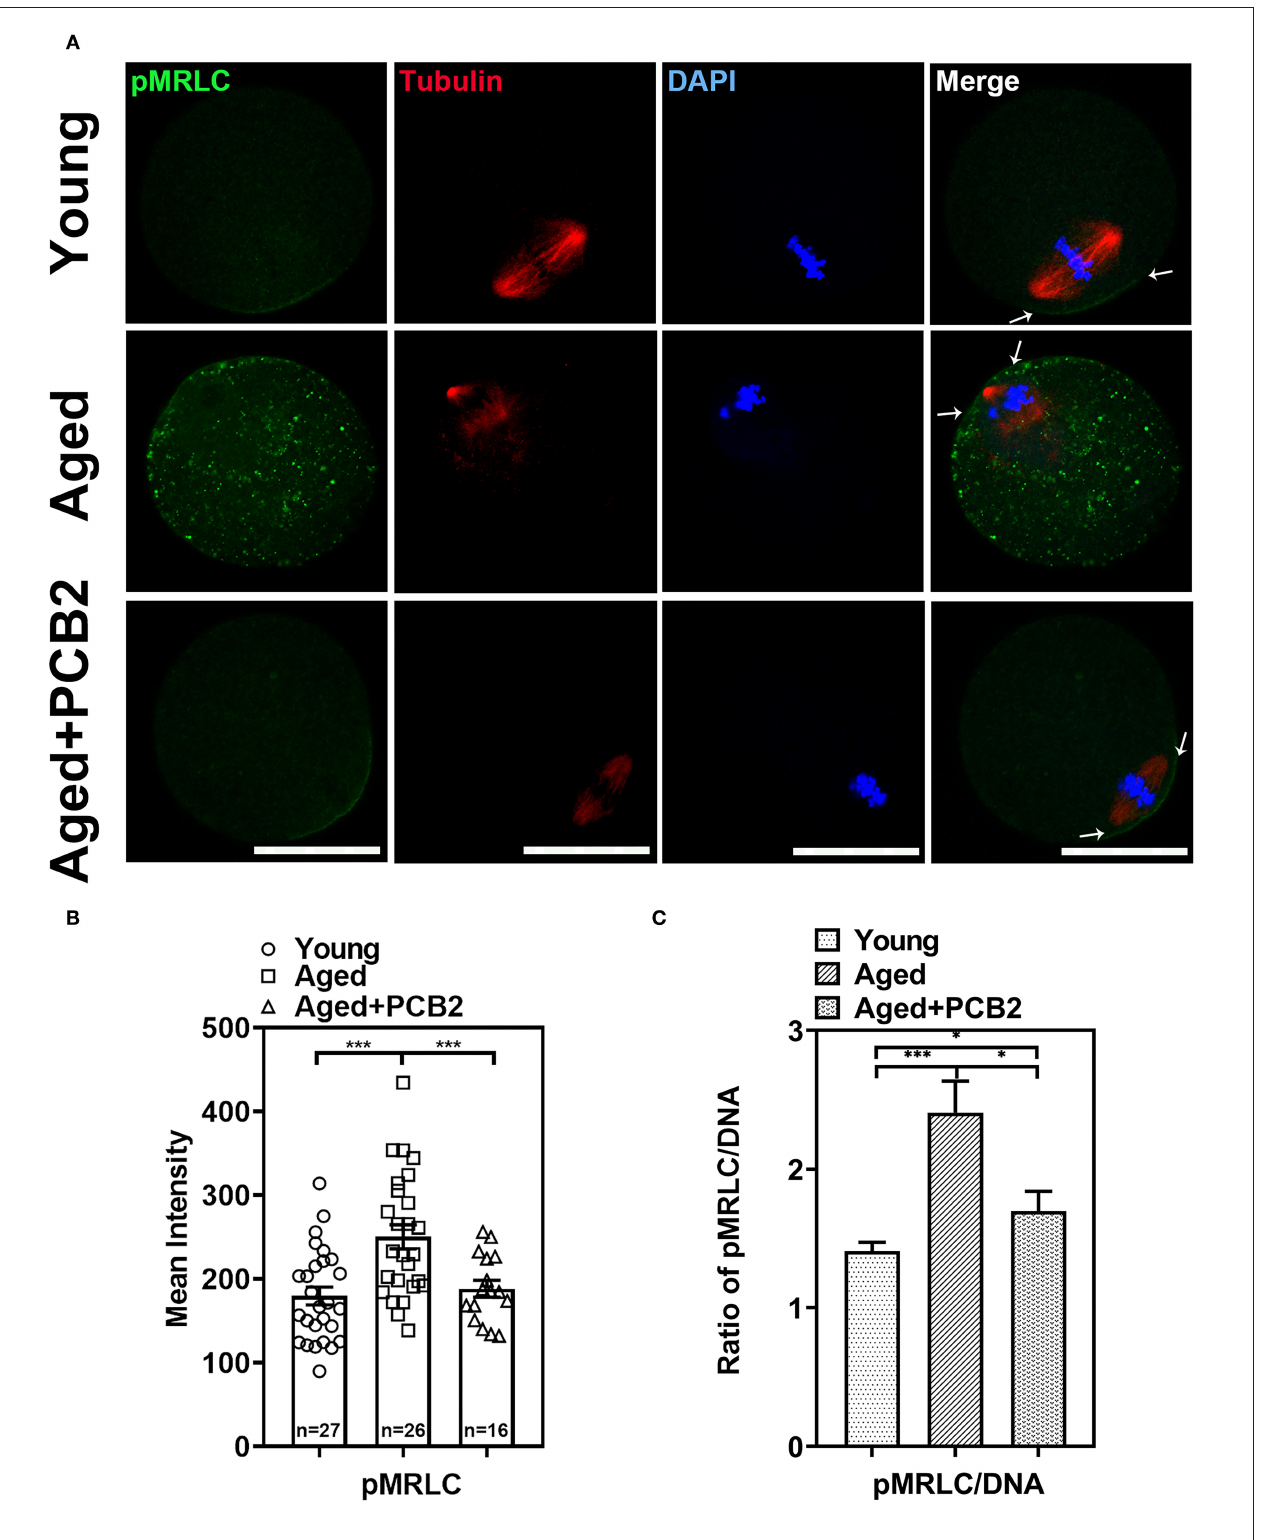
FIGURE 3 | Effects of PCB2 on pMRLC expression and spindle formation during in vitro culture of aged oocytes. (A) IF staining of in vitro matured oocytes for pMRLC and tubulin. DNA was counterstained with DAPI (blue). Scale bar, 50 µ m. (B) Fluorescence intensity of pMRLC signals was recorded in different groups. (C) The ratio of pMRLC to DNA fluorescence. Data are presented as mean percentage (mean ± SEM) of at least three independent experiments. * P < 0.05, *** P < 0.001. ns, non-significant difference, P > 0.05.